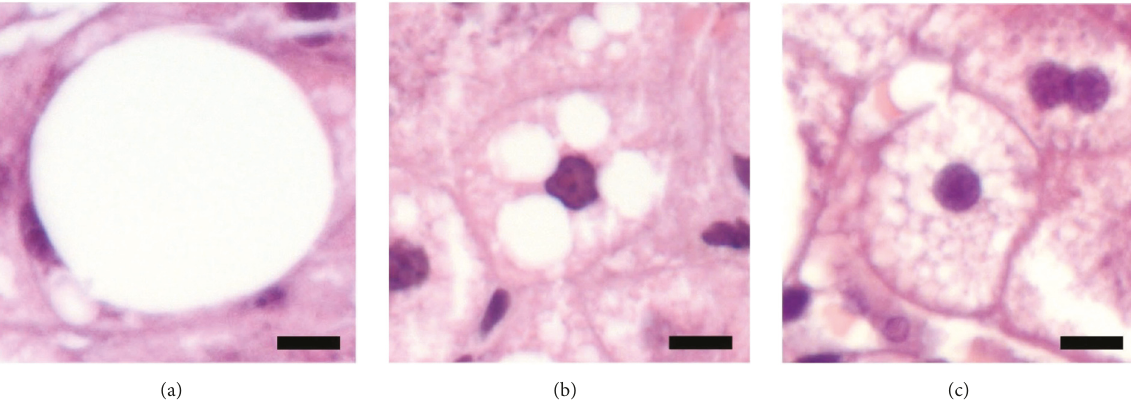
Figure 2: Representative images of Ld-MaS (a), Sd-MaS (b), and true microvesicular steatosis (c). In (a), a single fat vacuole displaced the nucleustoperipheryofthecell.Incontrast,multiplefatvacuolesnotdisplacingthenucleuswereconsideredthehallmarkof(b).In(c)steatosis was true microvesicular when many tiny lipid vesicles were diffusely distributed within the cytoplasm leading to a foamy